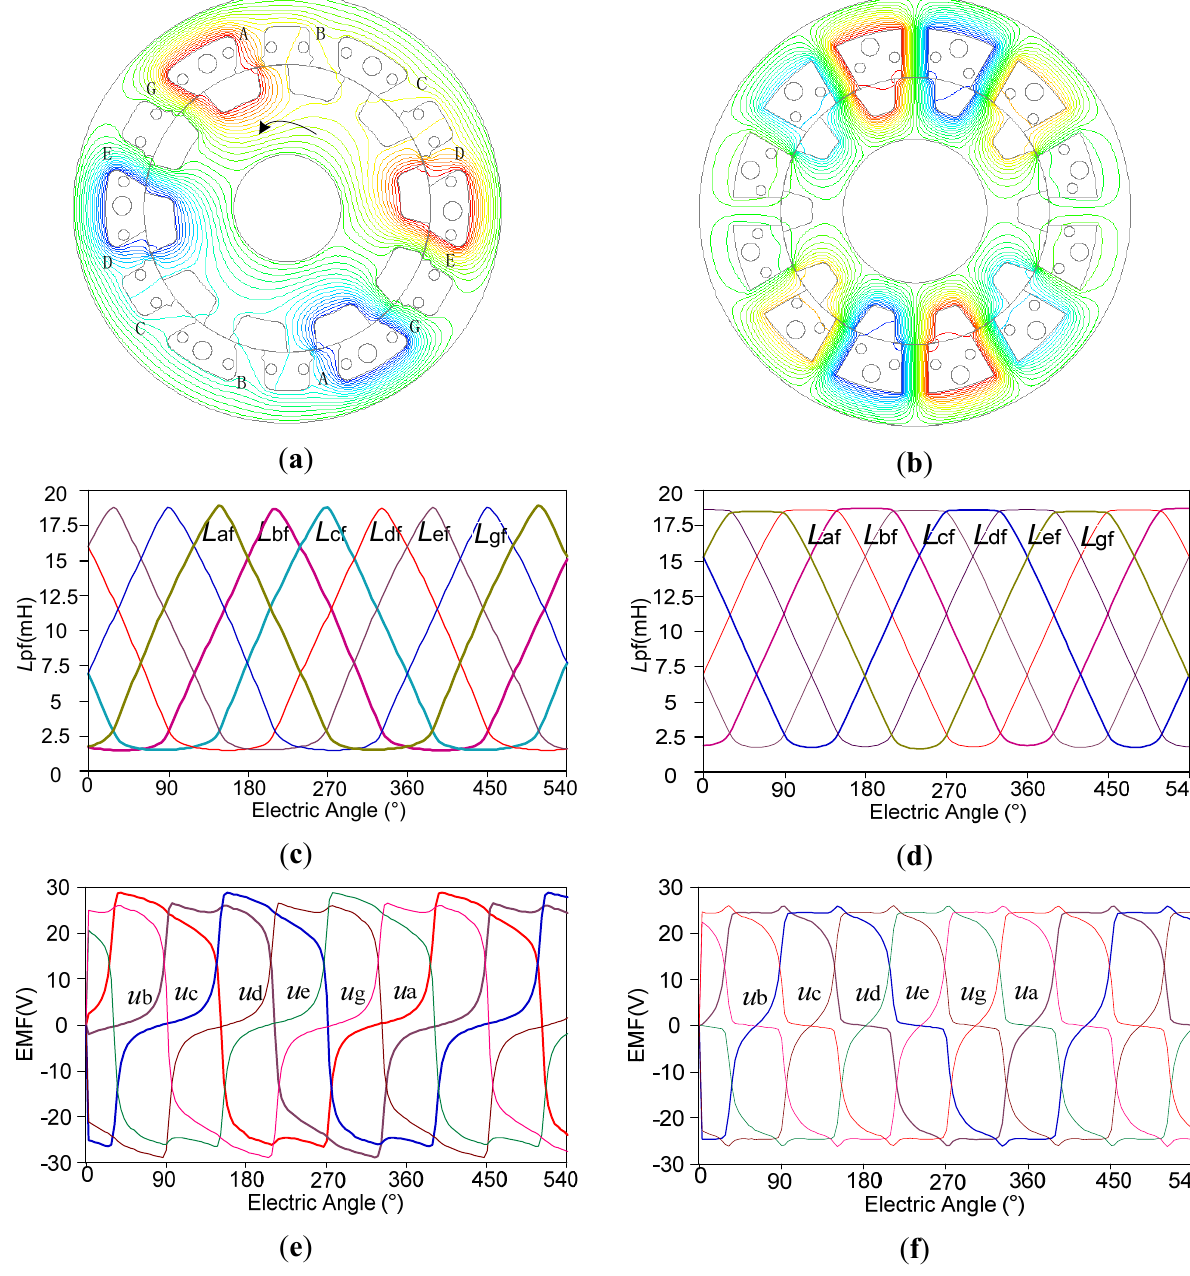
Figure 9. Comparison of the new 12/10-pole six-phase WFDSM. ( a ) The flux of the WFDSM with j = 2; ( b ) The flux of the WFDSM with j = 2. ( c ) L pf of the WFDSM with j = 2; ( d ) L pf of the WFDSM with j = 1; ( e ) Back EMF of the WFDSM with j = 2; ( f ) Back EMF of the WFDSM with j =